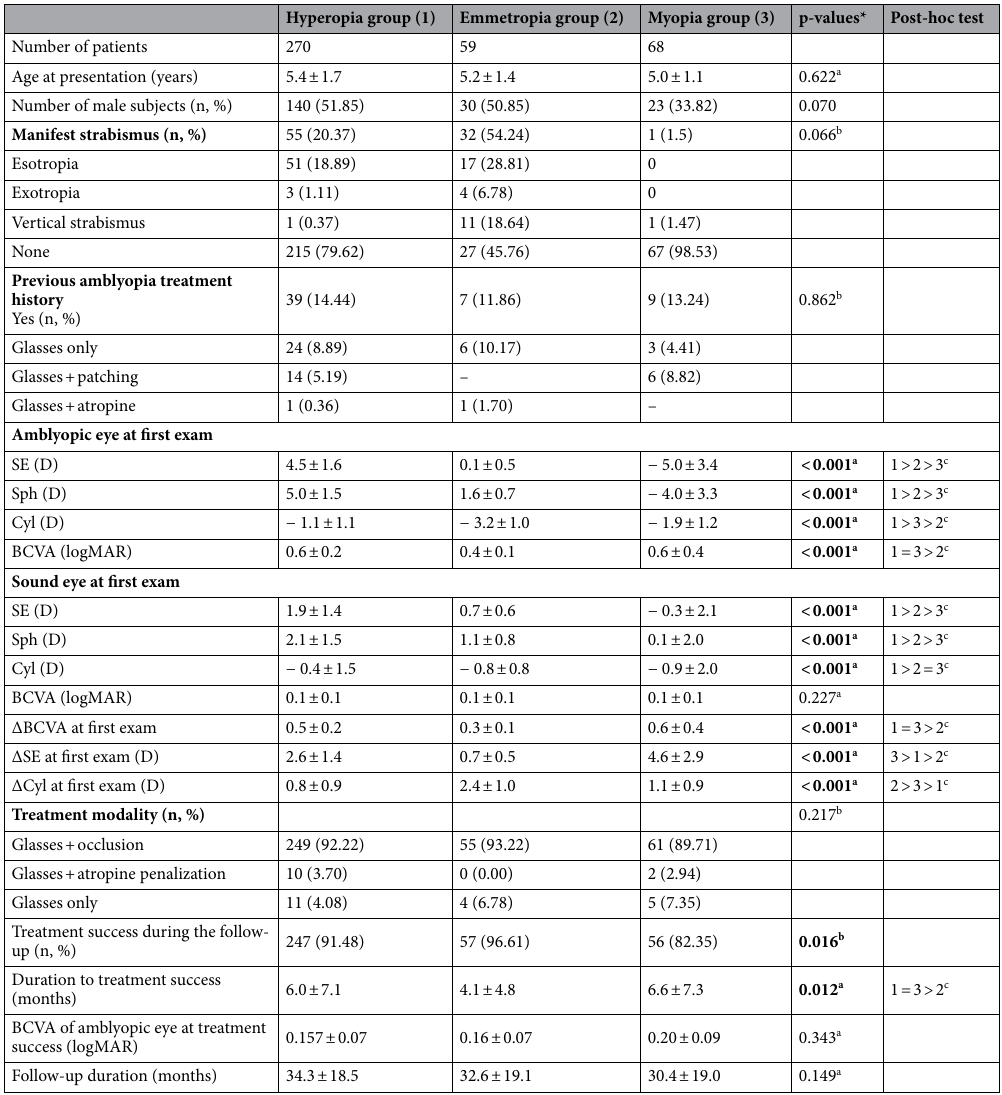
Table 1. Clinical characteristics of anisometropic amblyopia patients in hyperopic, emmetropic, and myopic amblyopia groups. Cylindrical error was described as negative values. Numeric values are expressed as mean ± standard deviation (SD), and categorical variables are expressed as number (%). SE spherical equivalent, Sph sphere component, Cyl cylinder component, BCVA best-corrected visual acuity, ΔBCVA difference of BCVA between the two eyes, ΔSE difference of SE between the two eyes, ΔCyl difference of cylinder between the two eyes. p-values* compare hyperopia, emmetropia, and myopia groups, and p-values < 0.05 are displayed in bold. a P-value using Kruskal–Wallis test. b P-value by Chi-squared test. c